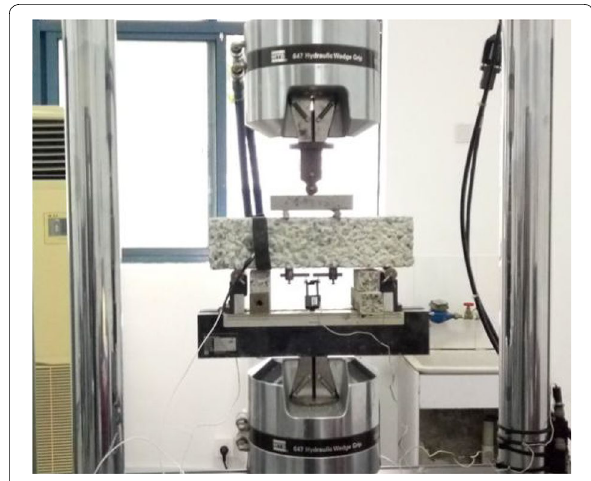
Fig. 3 Four-point bending test setup MTS810.